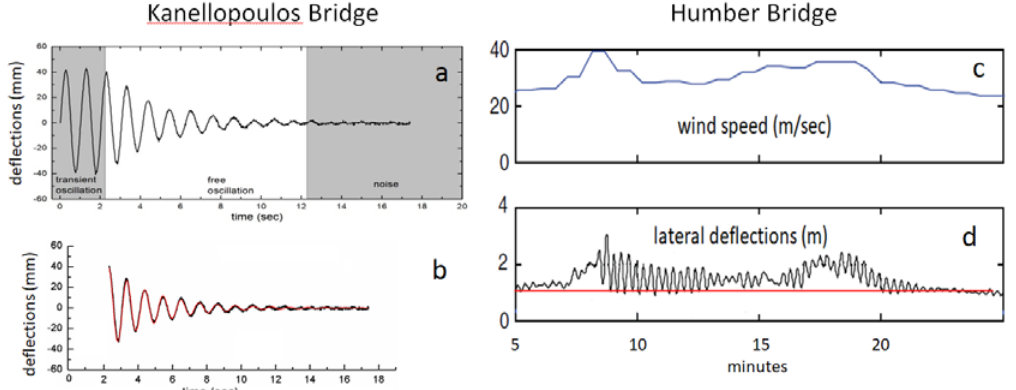
Figure 3. Semi-static and dynamic lateral oscillations in the Kanellopoulos and the Humber Bridge. ( a ) An example of forced, transient oscillation (shaded, left) followed by a free attenuation interval and an equilibrium interval (shaded, right) characterized by noise (after [2]); ( b ) The free attenuation interval in ( a ) (observed, black curve) approximated by an idealized curve (in red). Excellent match of the curves indicates a SDOF oscillation permitting accurate estimation of the first lateral modal frequency; ( c ) Wind record during an extraordinary wind event affecting the Humber Bridge, UK; ( d ) Recorded lateral deflections (deviations from red line) indicate a combination of semi-static bending with amplitude of up to 2 m and of dynamic high frequency oscillations produced by gusts, not shown in ( c ). ( c , d ) modified after Figure 17 in [5].